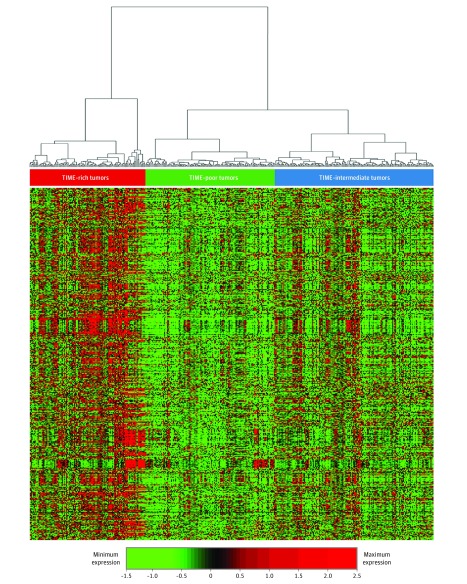
Heatmaps Showing the 3 Universal Tumor Immune Microenvironment (TIME) SubtypesA representative heatmap derived from the gene expression of immune checkpoint therapy essential genes, showing the TIME subtypes in head and neck squamous cell carcinoma. Heatmap based on log10 transformation of gene expression value. Green indicates minimum expression and red, maximum expression. Heatmaps for other cancer types are shown in eFigure 1 in the Supplement.